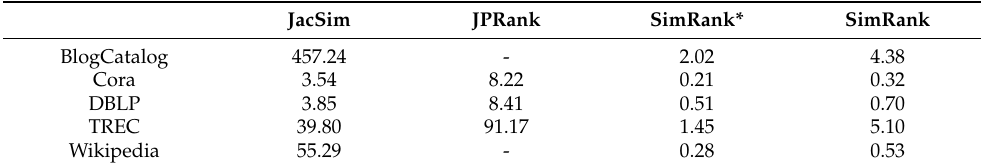
Table 15. Execution time (minutes) of all similarity measures with our datasets. JacSim JPRank SimRank* SimRank BlogCatalog